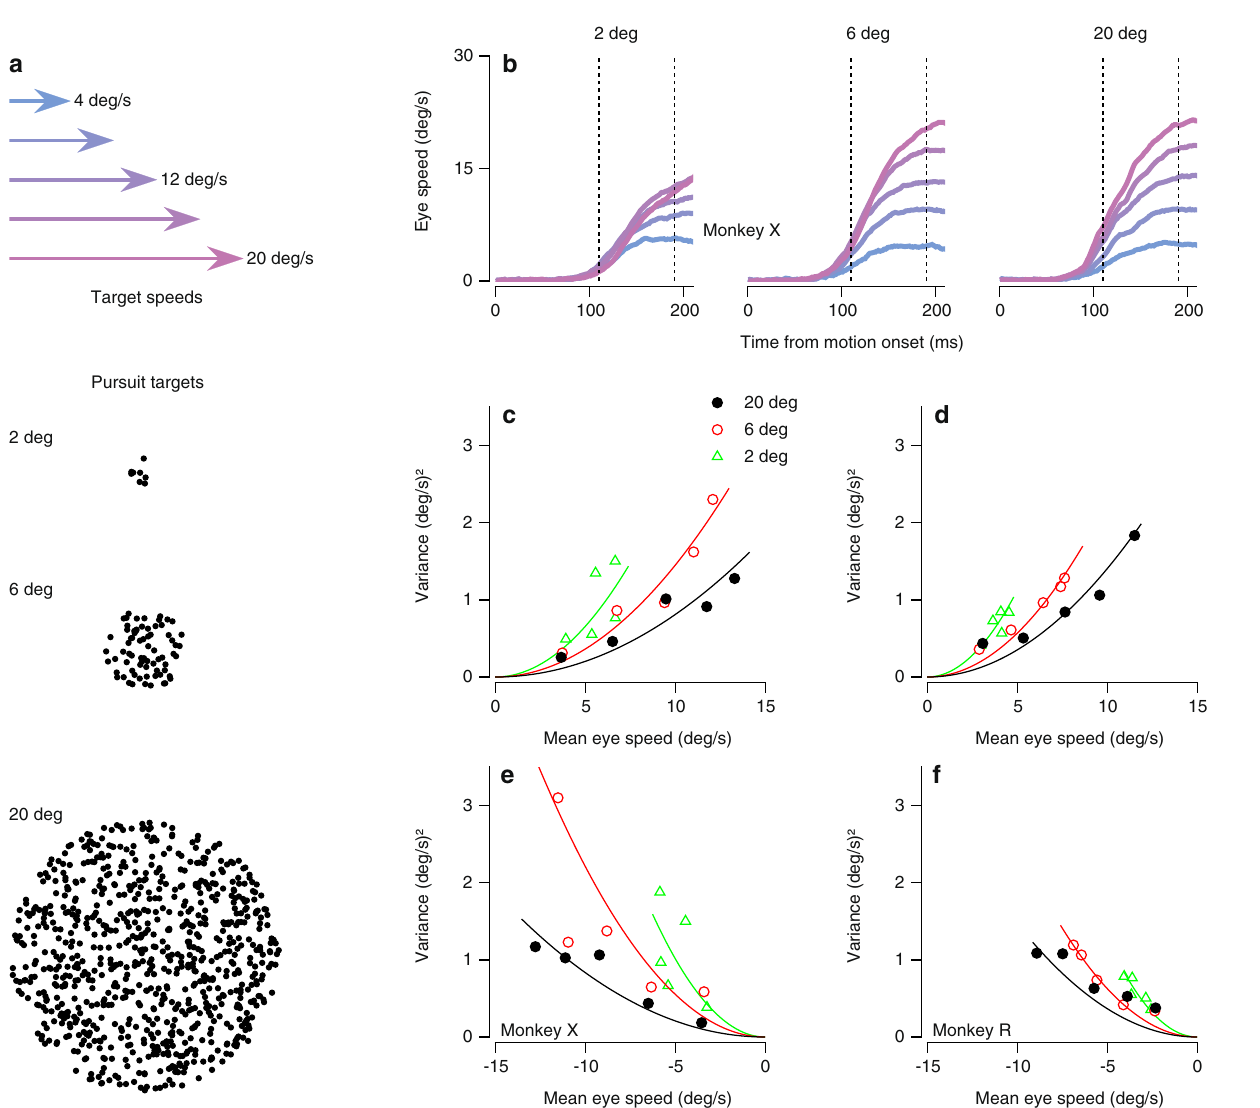
Fig. 1 Target size affects the relationship between the variance and mean of pursuit initiation. a Properties of pursuit stimuli. Top: Arrows indicate target speeds. Dot patches moved at a speed selected from a discrete uniform distribution with 5 values evenly spaced between 4 to 20 deg/s (colors). Bottom: Example dot patches corresponding to targets of three different sizes: 2 deg, 6 deg, and 20 deg. b Mean pursuit initiation behavior for monkey X, sorted by target speed (colors; see arrows in panel a ) and patch size indicated at the top of each graph. Each trace shows trial-averaged eye speed as a function of time, starting at the time of target motion onset. Vertical dashed lines indicate the window of time averaging used for subsequent analyses. c Variance of eye speed of monkey X plotted against the mean eye speed for rightward pursuit. Symbols plot the behavior for different target speeds and sizes. Curves indicate the fi t of a signal-dependent noise model where the Weber fraction is allowed to change with target size. d As in panel c , but for rightward pursuit in monkey R. e As in panel c , but for leftward pursuit in monkey X. f As in panel c , but for leftward pursuit in monkey R. c – f , Green, red, and black symbols and curves show results for target sizes of 2, 6, and 20 deg, respectively. Source data are provided as a Source Data fi